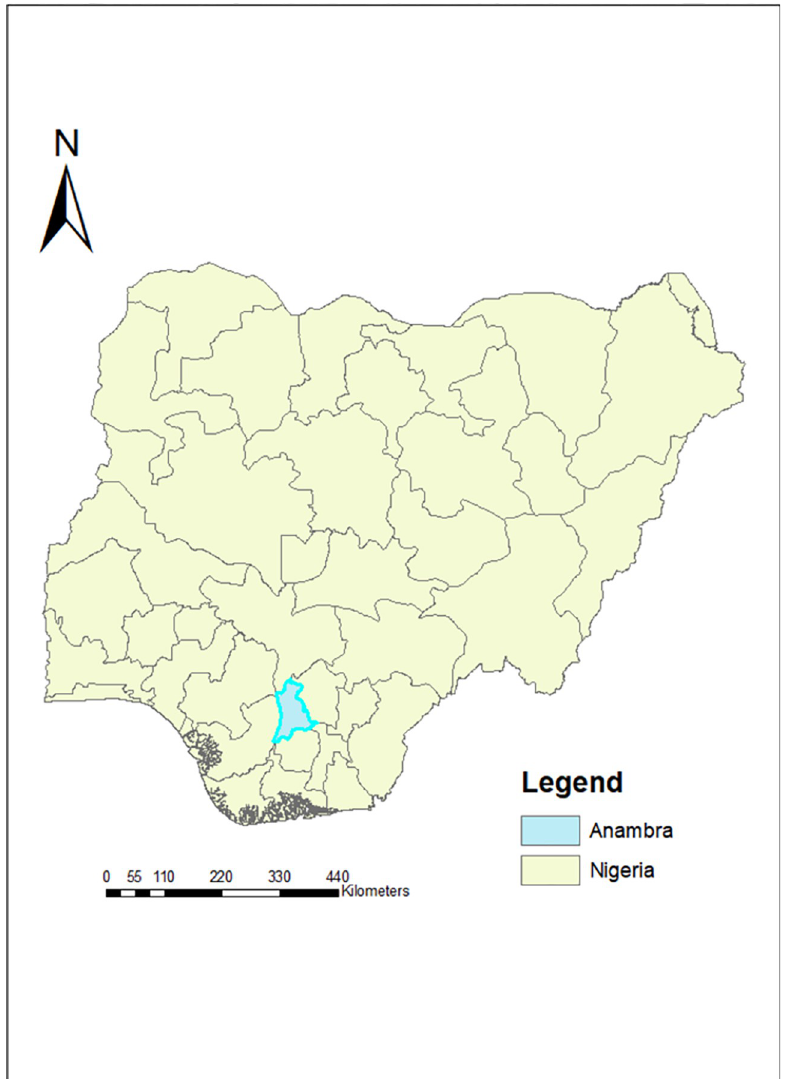
Fig 1. Map of Nigeria showing Anambra State. Source: The authors created this map in ArcGIS 9.3 software. The basemap shapefiles of the 37 administrative units in Nigeria unto which we plotted our map were downloaded from